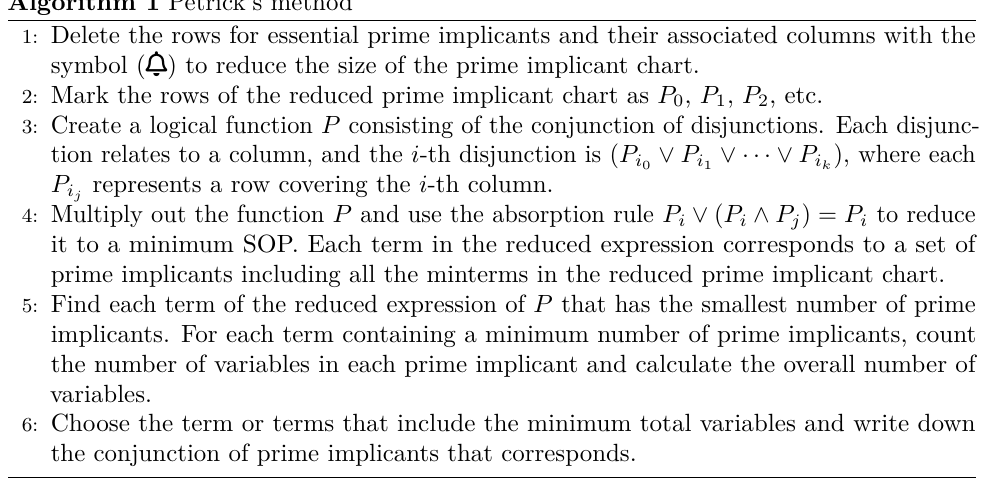
Algorithm 1 Petrick’s method